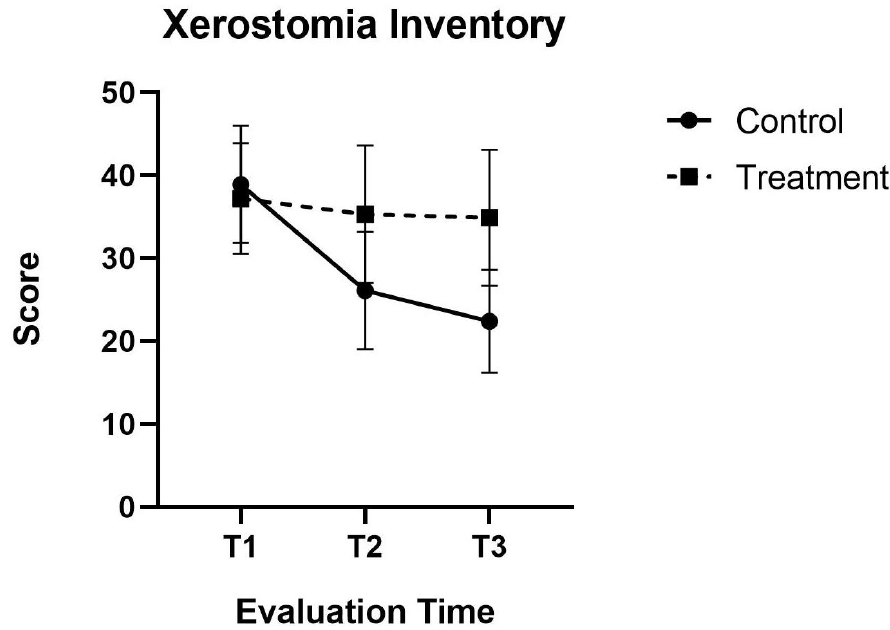
Figure 2. Xerostomia Inventory (XI) Graphs comparing mean ( ± SD) score at baseline (T1), After 2 weeks of therapy final session (T2) At the end of therapy 6 weeks (T3) experimental laser and control group.